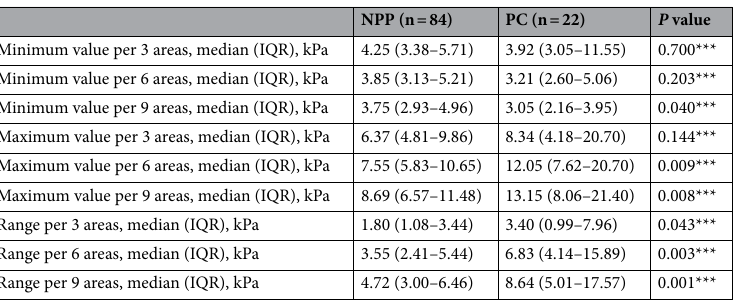
Table 4. Comparison of elastic modulus variability between normal pancreatic parenchyma group and pancreatic cancer group. NPP normal pancreatic parenchyma, PC pancreatic cancer, IQR interquartile range. *Mann–Whitney U test.